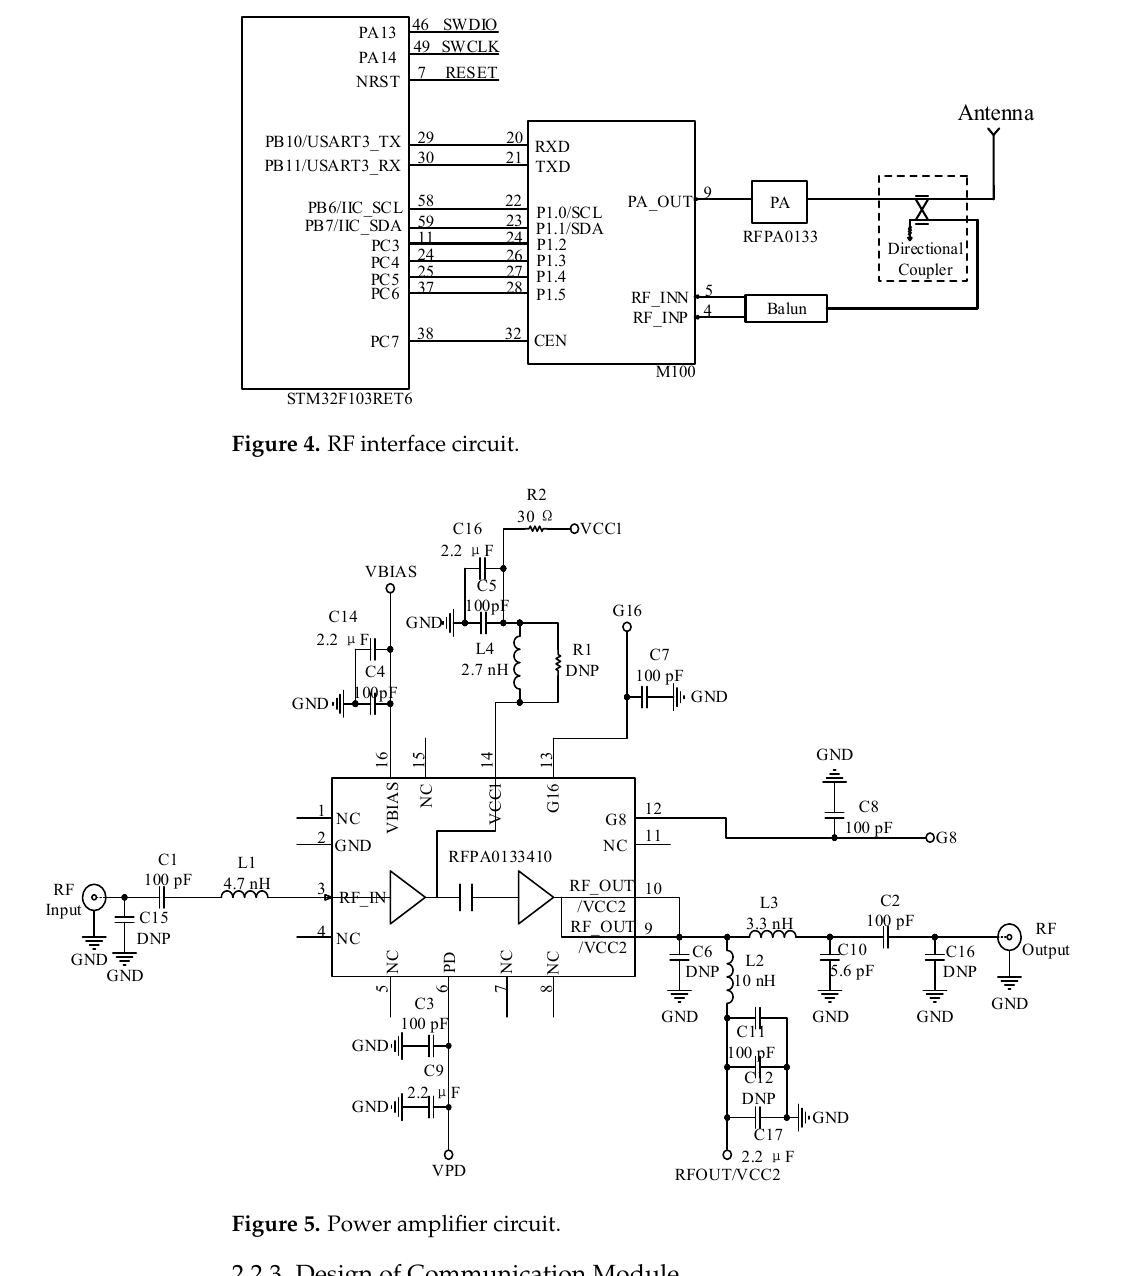
Figure 5. Power ampli fi er circuit.